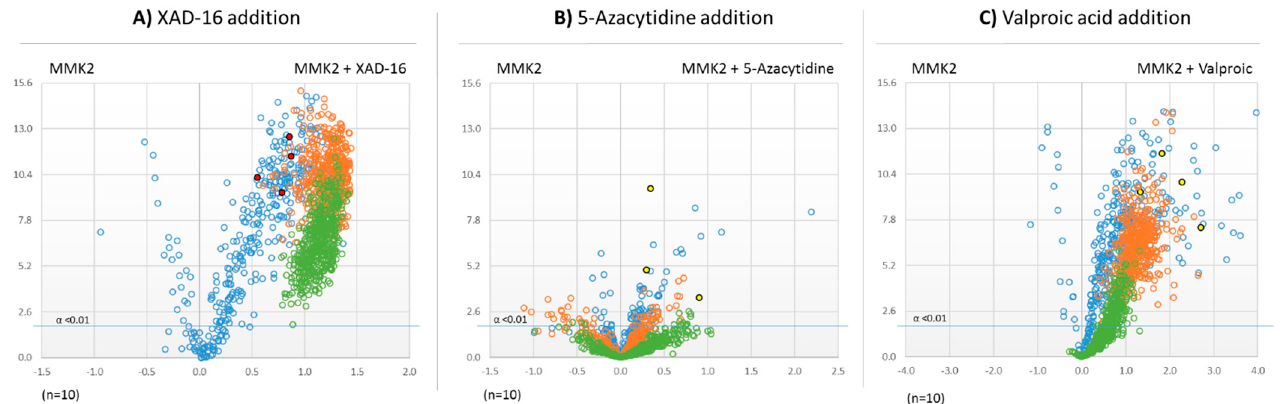
Figure 4. Volcano-plot statistical untargeted metabolomics comparison of the three fermentation additives tested versus their corresponding MMK2 control medium condition: ( A ) when XAD-16 adsorptive polymeric resin was added; ( B ) when the DNMT inhibitor 5-azacytidine was added; ( C ) when the HDAC inhibitor valproic acid was added ( n = 10; α < 0.01). In blue the pseudomolecular ions m/z < 500 Da, in orange pseudomolecular ions m/z between 1000 and 1500 Da and in green pseudomolecular ions m/z > 1500 Da. Highlighted in other colours are the pseudomolecular ions responsible for the induced antitumoural activity of the compounds (see Identification of Bioactive compounds Section). − Log 10 of t -test statistical p -value in y-axis vs. − log 2 of m/z ion masses areas ratios in x-axes.